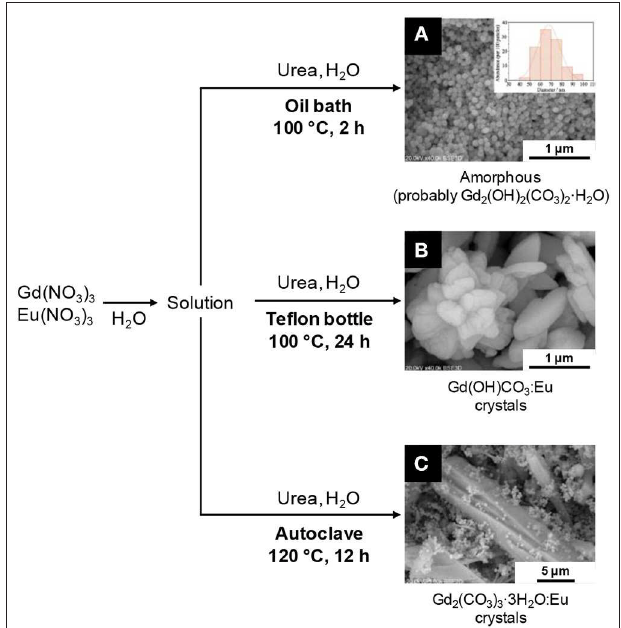
FIGURE 13 | Structural and morphological variations of Gd 2 O 2 S precursors obtained by Cichos et al. (2016). Depending on the heating process, strong variations are observed: amorphous spherical nanoparticles ( A with the size distribution in inset), hydroxycarbonate microcrystals (B) or carbonate microcrystals (C) can be obtained. Adapted from Cichos et al. (2016) with permission of